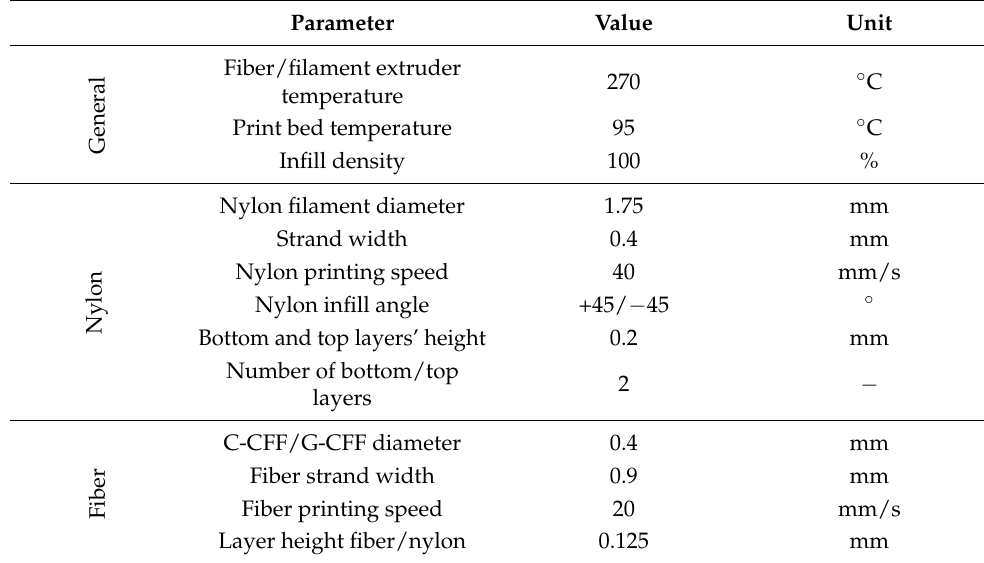
Figure 2. Printing process of hybrid tensile specimens with carbon and glass fibers in intraply approach. Table 1. Used process parameters to manufacture the